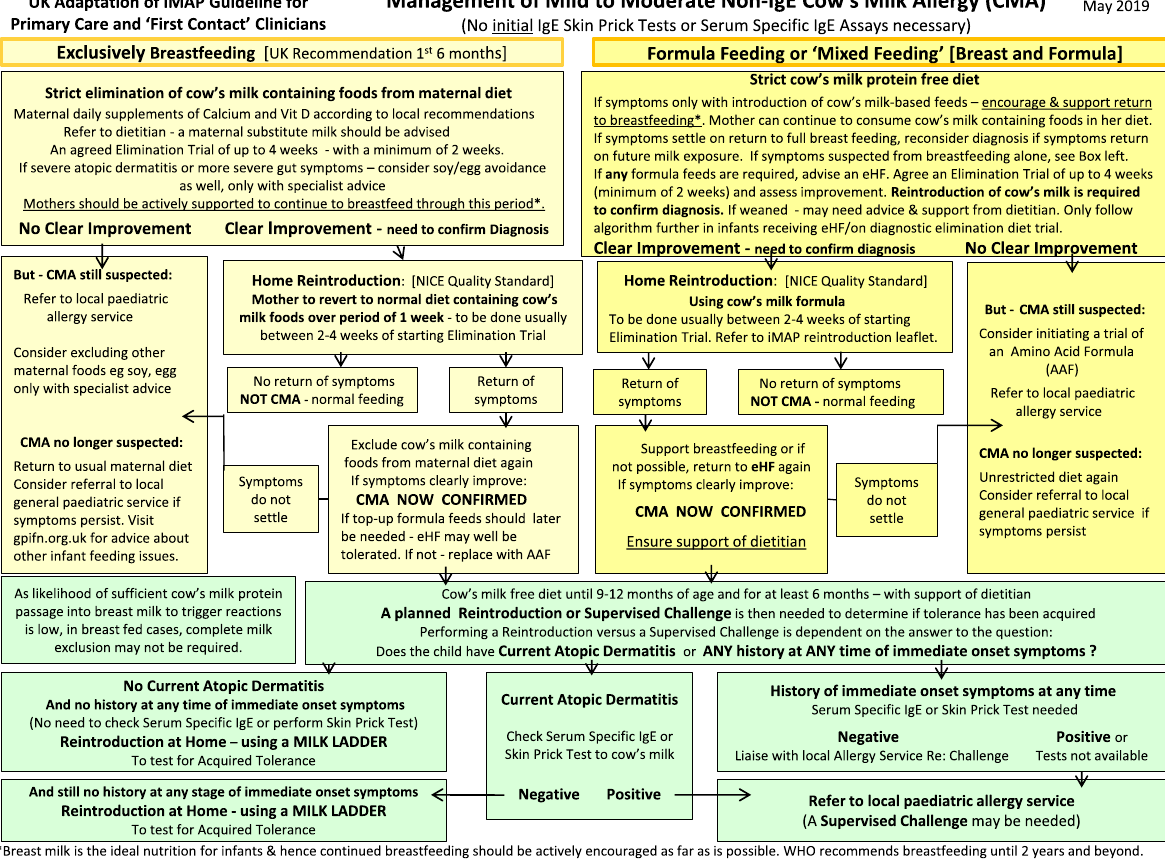
Fig. 2 Management of mild to moderate non‑IgE cow’s milk allergy